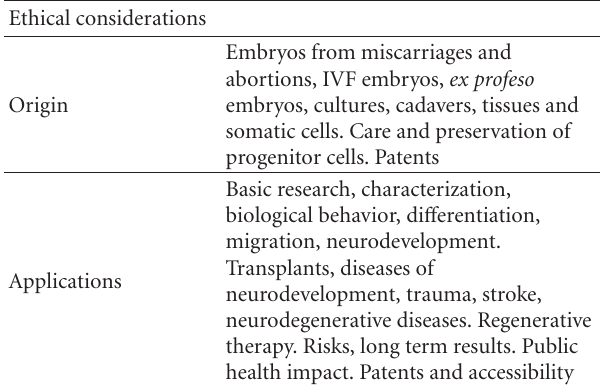
Table 1: Ethical considerations in the use of neural stem cells. Ethical considerations related to the origin and source of neural stem cells and the potential clinical